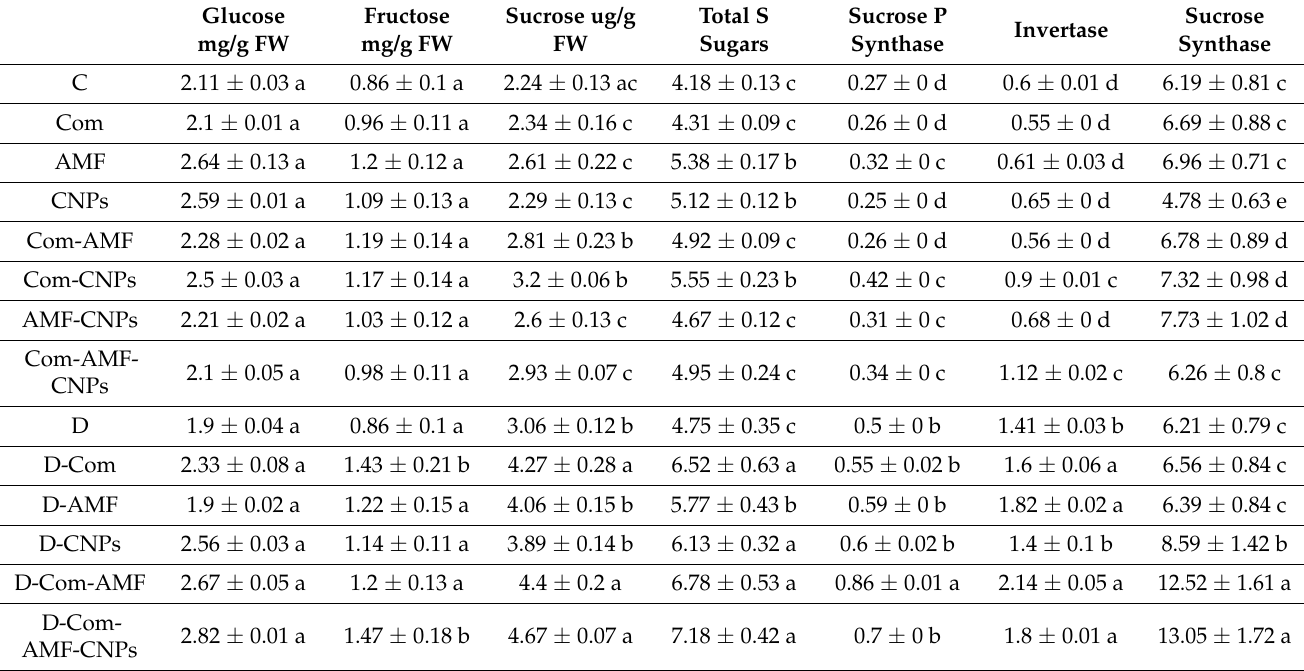
Table 1. Effect of different treatments on sugar contents of maize under control and drought (D) conditions. Different letters indicate statistically significant difference between means for the different treatments at significance level of at least p ≤ 0.05. C: control, Com: compost, AMF: mycorrhiza, CNPs: carbon nanoparticles, D: